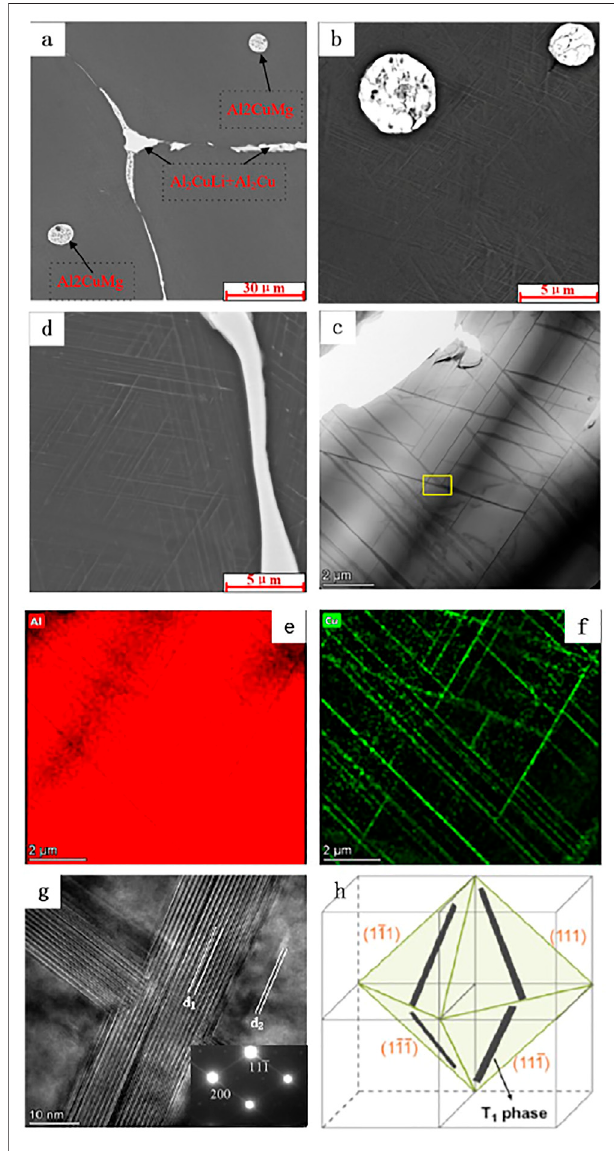
FIGURE 6 | X-ray diffraction spectrum of 2195 aluminum – lithium alloy ingot mainly containing Li phase. (A – C) Microstructure of ingot, (D) TEM bright- fi eld image of needle-like phase, (E,F) EDS composition detection of needle-like phase, (G) high-resolution photo of T1 phase and Al matrix and diffraction spots, (H) four groups of T1 phase diagrams located on the (111) Al